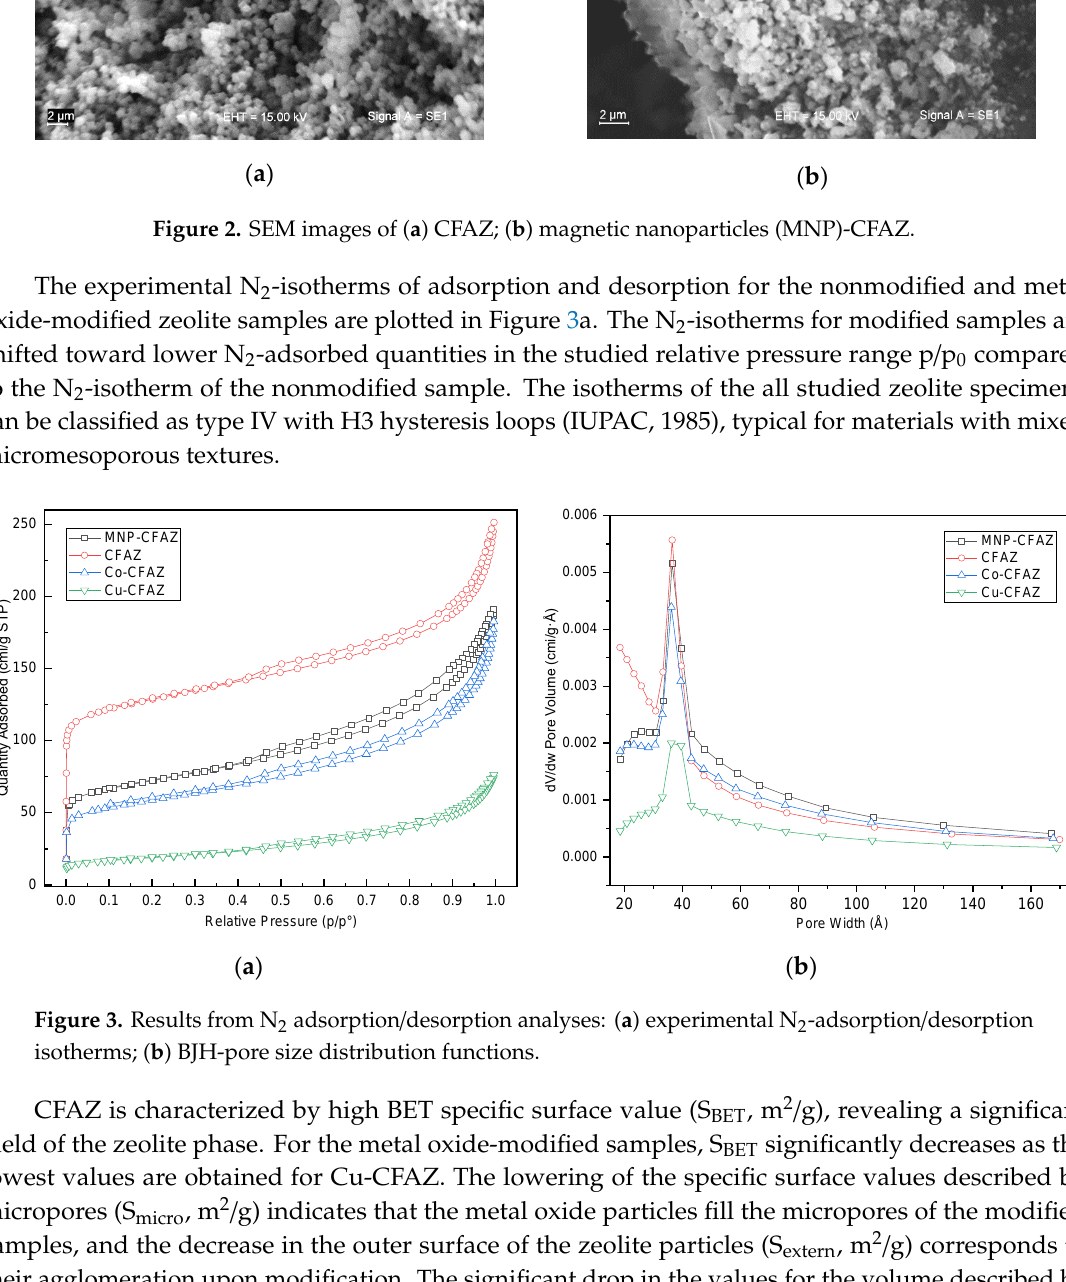
Figure 3. Results from N 2 adsorption/desorption analyses: ( a ) experimental N 2 -adsorption/desorption isotherms; ( b ) BJH-pore size distribution functions.